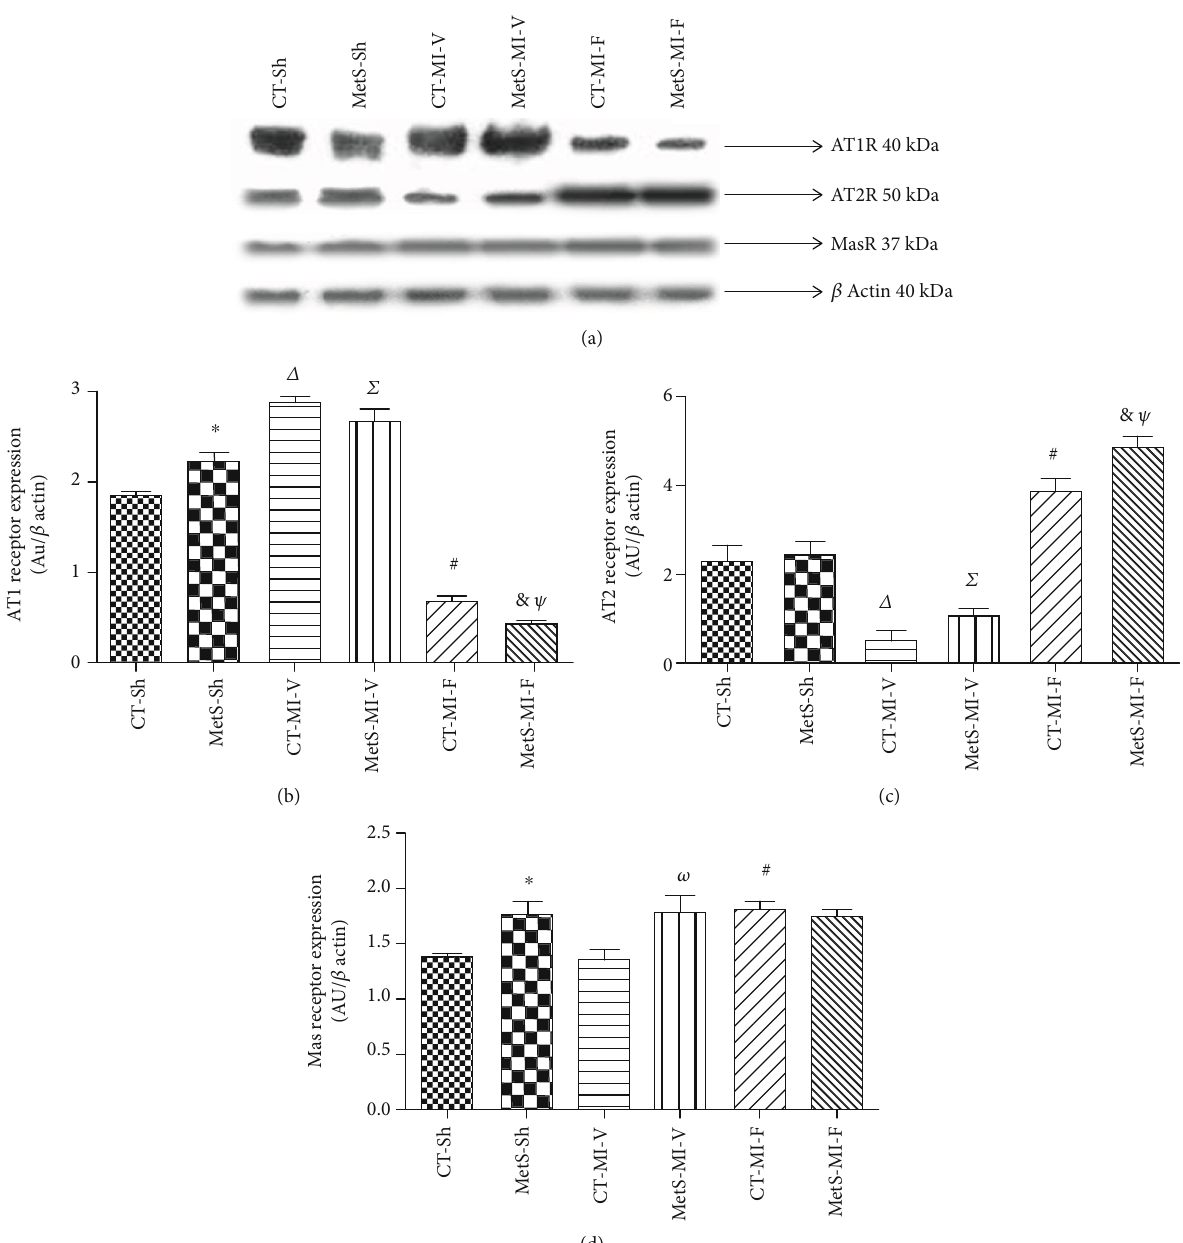
Figure 3: Expression of cardiac angiotensin receptors. The proteins were evaluated in the left ventricles from the control (CT) and metabolic syndrome (MetS) rats subjected to sham (Sh) or myocardial infarction (MI) and treated for two weeks with either vehicle (V) or feno fi brate (F). (a) Representative immunoblot. (b) Angiotensin II-type 1 receptor (AT1R) protein expression. (c) Angiotensin II-type 2 receptor (AT2R) protein expression. (d) MasR protein expression. The values show the mean ± SEM ( n = 5 per group). ∗ p < 0 : 05 vs. CT-Sh; Δ p < 0 : 05 vs. CT- Sh; Σ p < 0 : 05 vs. MetS-Sh; # p < 0 : 05 vs. CT-MI-V; ω p < 0 : 05 vs. CT-MI-V; & p < 0 : 05 vs. MetS-MI-V; Ψ p < 0 : 05 vs. CT-MI-F. Analysis of